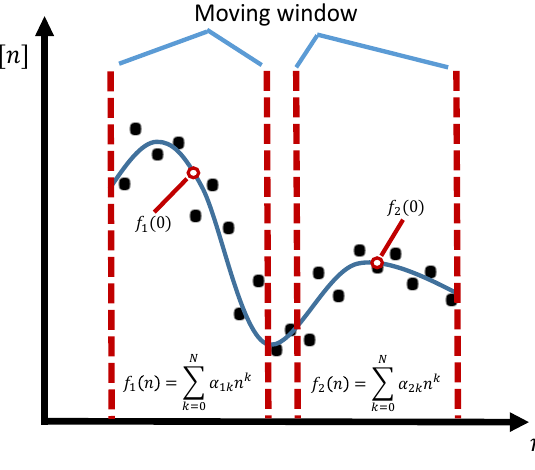
Figure 1. Illustration of the basic idea of SG